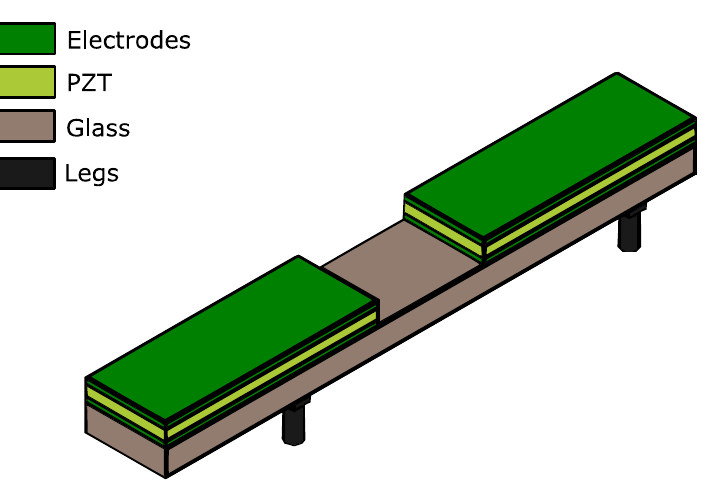
Figure 1. Schematic of the piezoelectric robot structure under study.